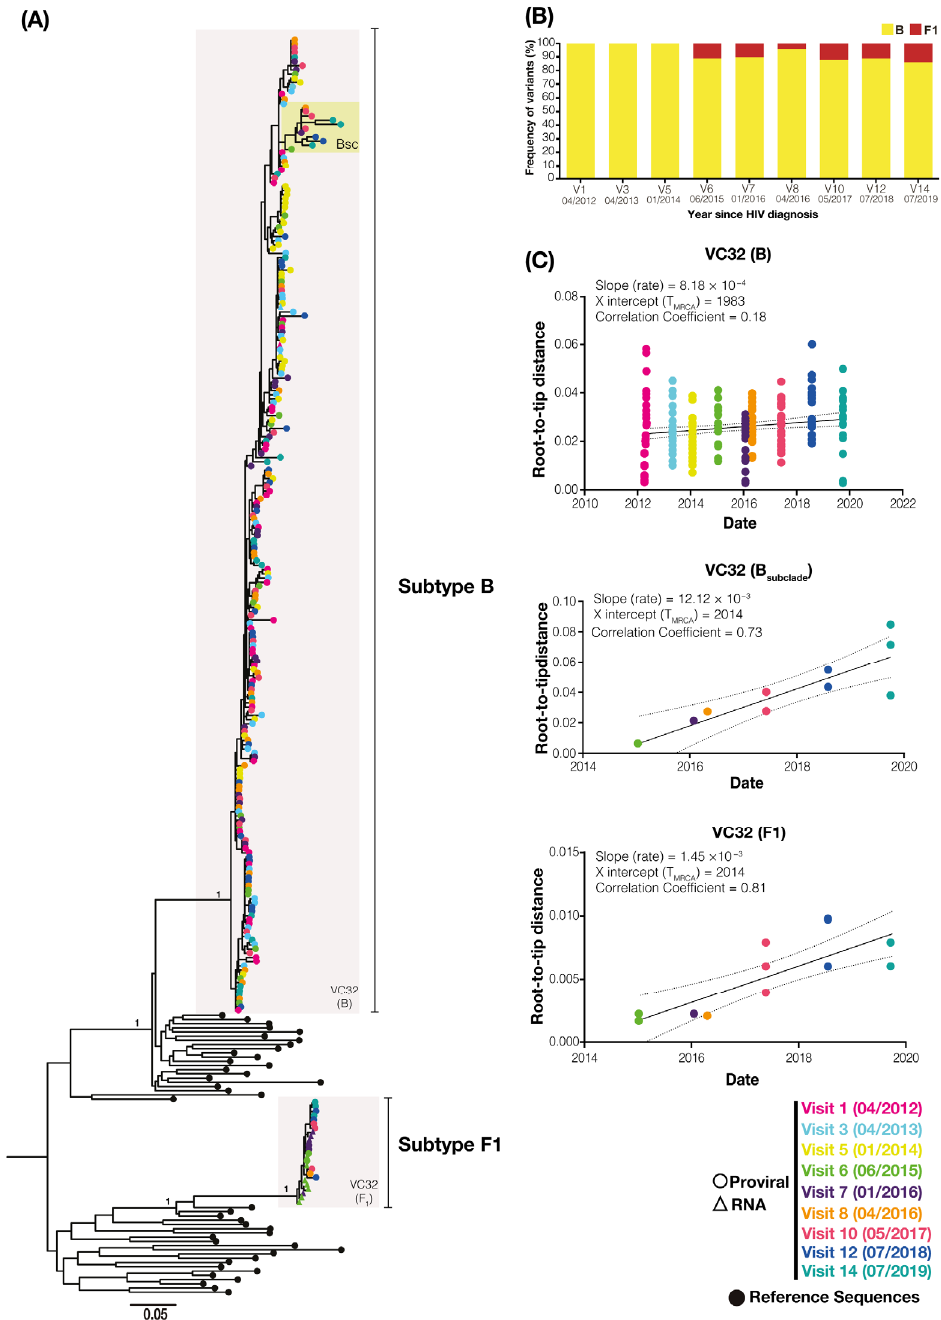
Figure 3. HIV-1 env gene sequences detected during follow-up of subject VC32. ( A ) Longitudinal analysis of HIV-1 PBMC-associated DNA (circles) and plasma RNA (triangle) env sequences obtained from individual VC32 between 2012 and 2019. Circles in the tips of the ML phylogenetic tree are colored according to the visit analyzed as shown in the legend at the bottom right. The shaded gray boxes highlight monophyletic clusters corresponding to each viral variant and the shaded yellow box indicates the monophyletic sub-cluster BSC. Black circles point to the reference sequences and vertical lines indicate subtype-specific clades (B and F1). Horizontal branch lengths are proportional to the bar at the bottom indicating nucleotide substitutions per site. The aLRT support is shown for key nodes. ( B ) The percentage of each viral variant at the PBMC compartment over time (years) is shown on the left Y-axis. ( C ) The plot of the root-to-tip distance against sequence sampling time of each viral variant. The colors of the circles represent the sampling time of DNA viral sequences according to the legend at the bottom right.